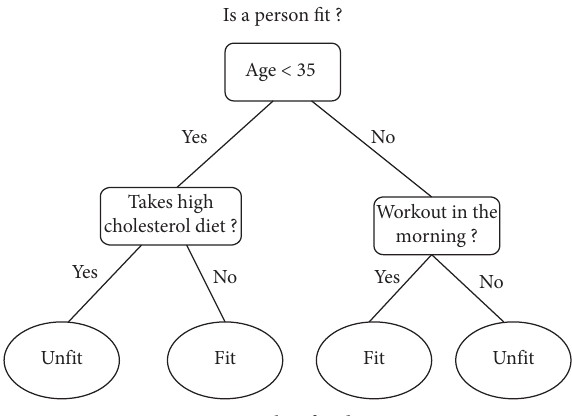
Figure 1: Example of a decision